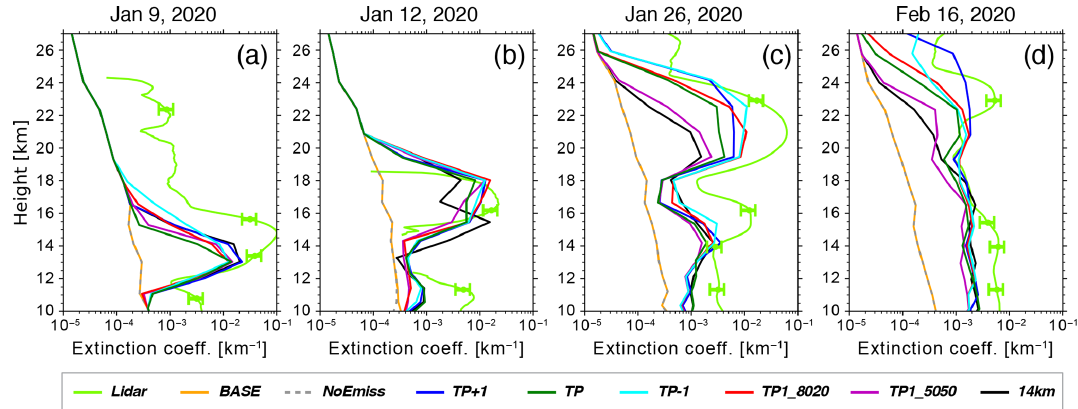
Figure 4. Comparison of modeled and observed profiles of aerosol extinction coefficients at the field site in Punta Arenas for 9, 12, and 26 January and 16 February 2020. Error bars indicate the estimated lidar measurement uncertainties of 30%. Values below the lidar detection limit are omitted from the graph. See Table 1 for details of the different